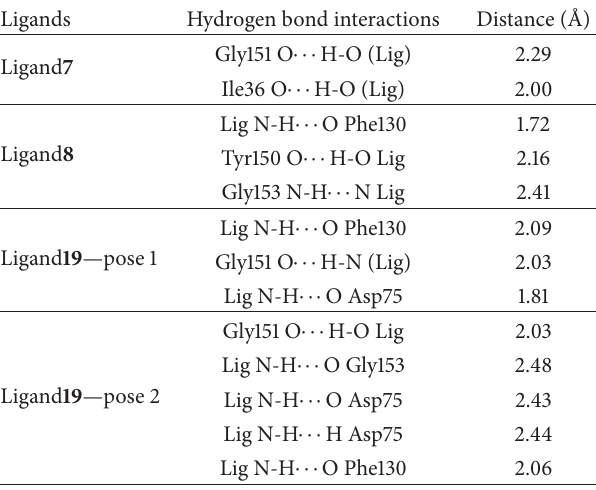
Table 3: The best poses and their hydrogen bond distance in